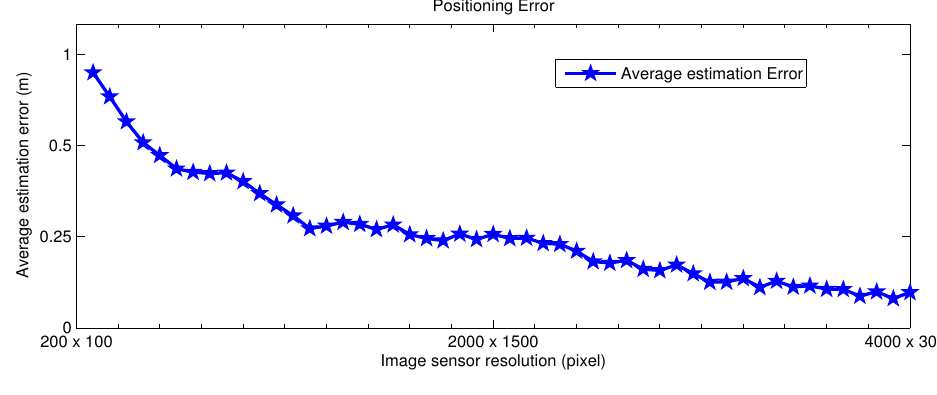
Figure 6. Estimation of error improvement along with the increase in IS